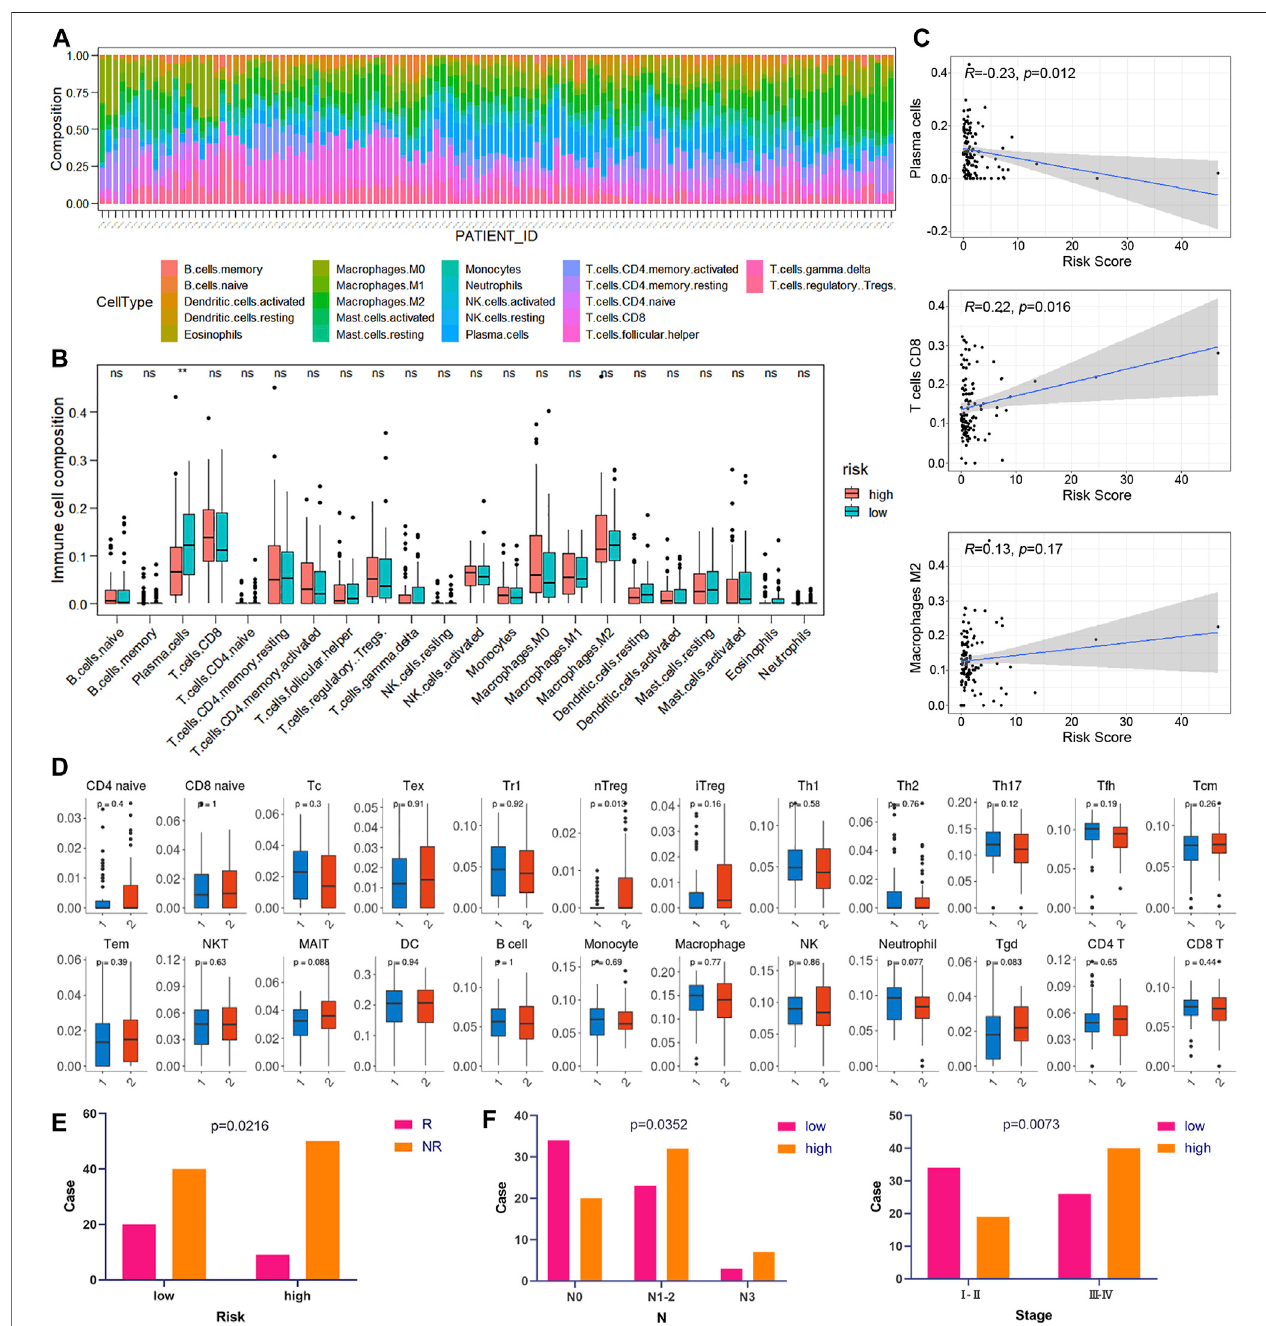
FIGURE8| Correlationbetweenriskscoreandimmunity. (A) Relativepercentage of22kindsofimmunecellsintumorsamples. (B) Boxplotsofthein fi ltrationlevel of22kindsofimmunecellsinthehigh-riskandlow-riskgroups. (C) Correlationdiagramsoftheriskscoreandimmunecells. (D) Theboxplotsshowthedifferencesinthe proportions of 24 kinds of immune cells between the high- and low-risk groups using ImmuCellAI. (1: low-risk, 2: high-risk). (E) The correlations between the risk score and ICB response. (F) The correlations between the risk score and different clinical features.